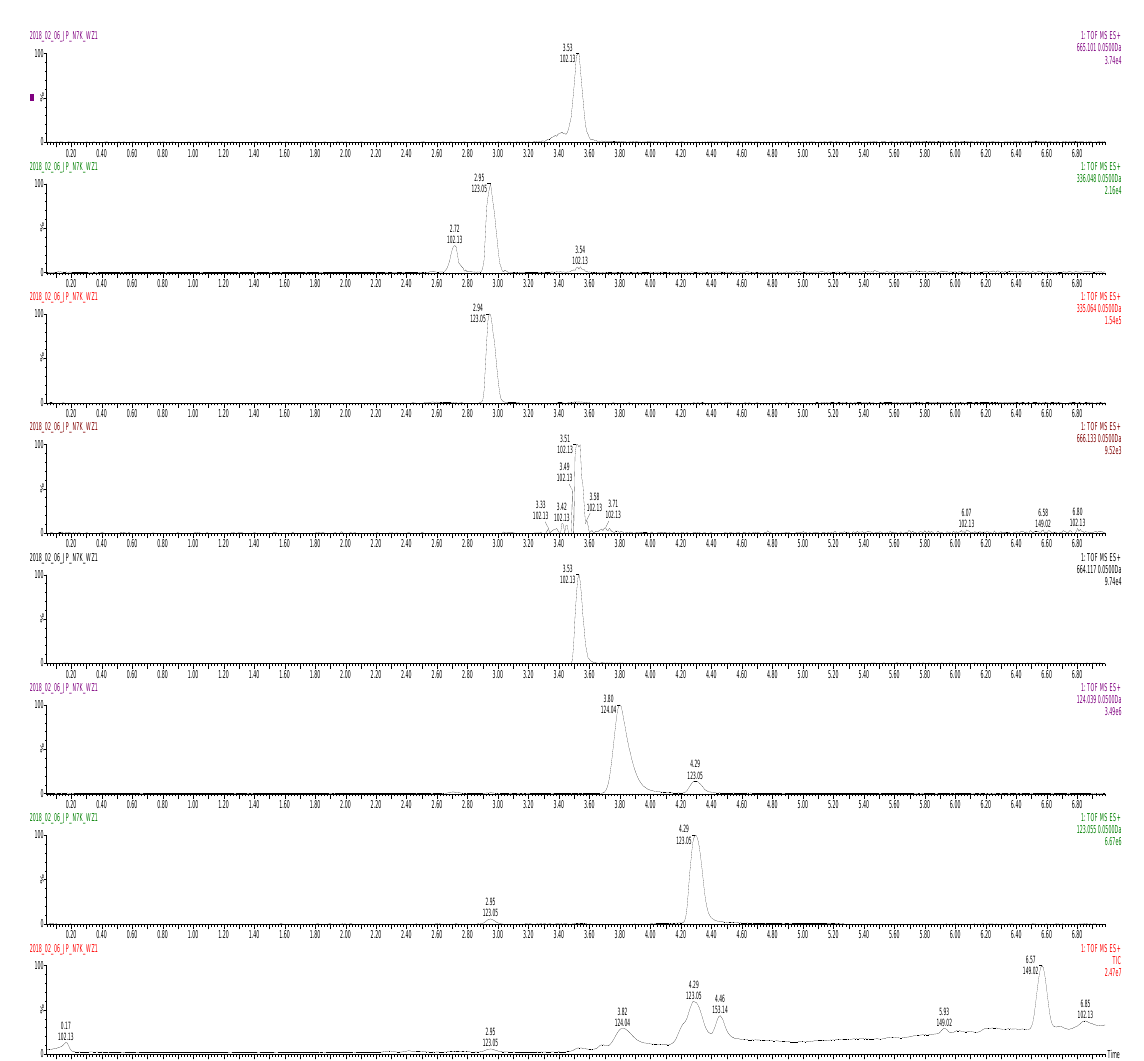
Table 2. Percentage gradient distribution of mobile phases during chromatographic separation of LC-MS/MS for nucleotide-related metabolites (phase A—10 mM of ammonium acetate with 0.1%